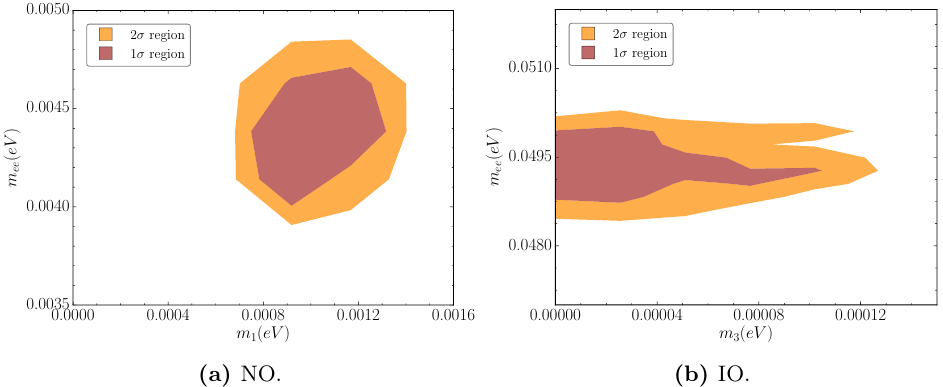
Figure 12. Allowed regions of the mass of the lightest neutrino mass eigenstate ( m 1 for (a) NO and (b) m 3 for IO) and the e(cid:11)ective neutrino mass parameter m ee appearing in neutrinoless double beta